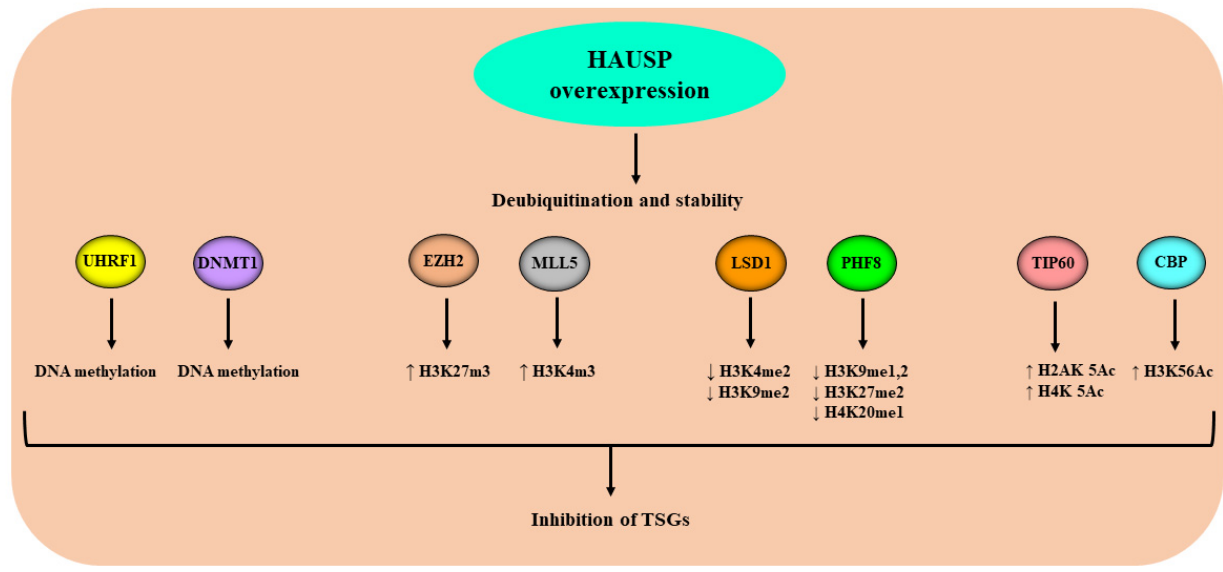
Figure 4. Schematic representation of the effect of HAUSP overexpression in cancer on the chromatin effector proteins and the related downstream events. High expression of HAUSP in cancer deubiquitinate and stabilizes the chromatin effector proteins causing abnormal DNA methylation and histone post-translational modifications which contribute to the silencing epigenetic of TSGs.